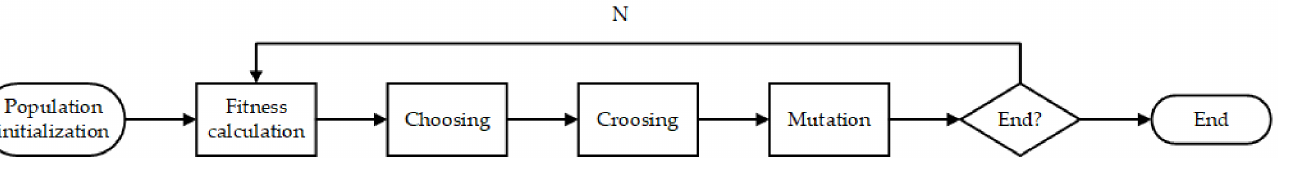
Algorithm 1 Overview of GA